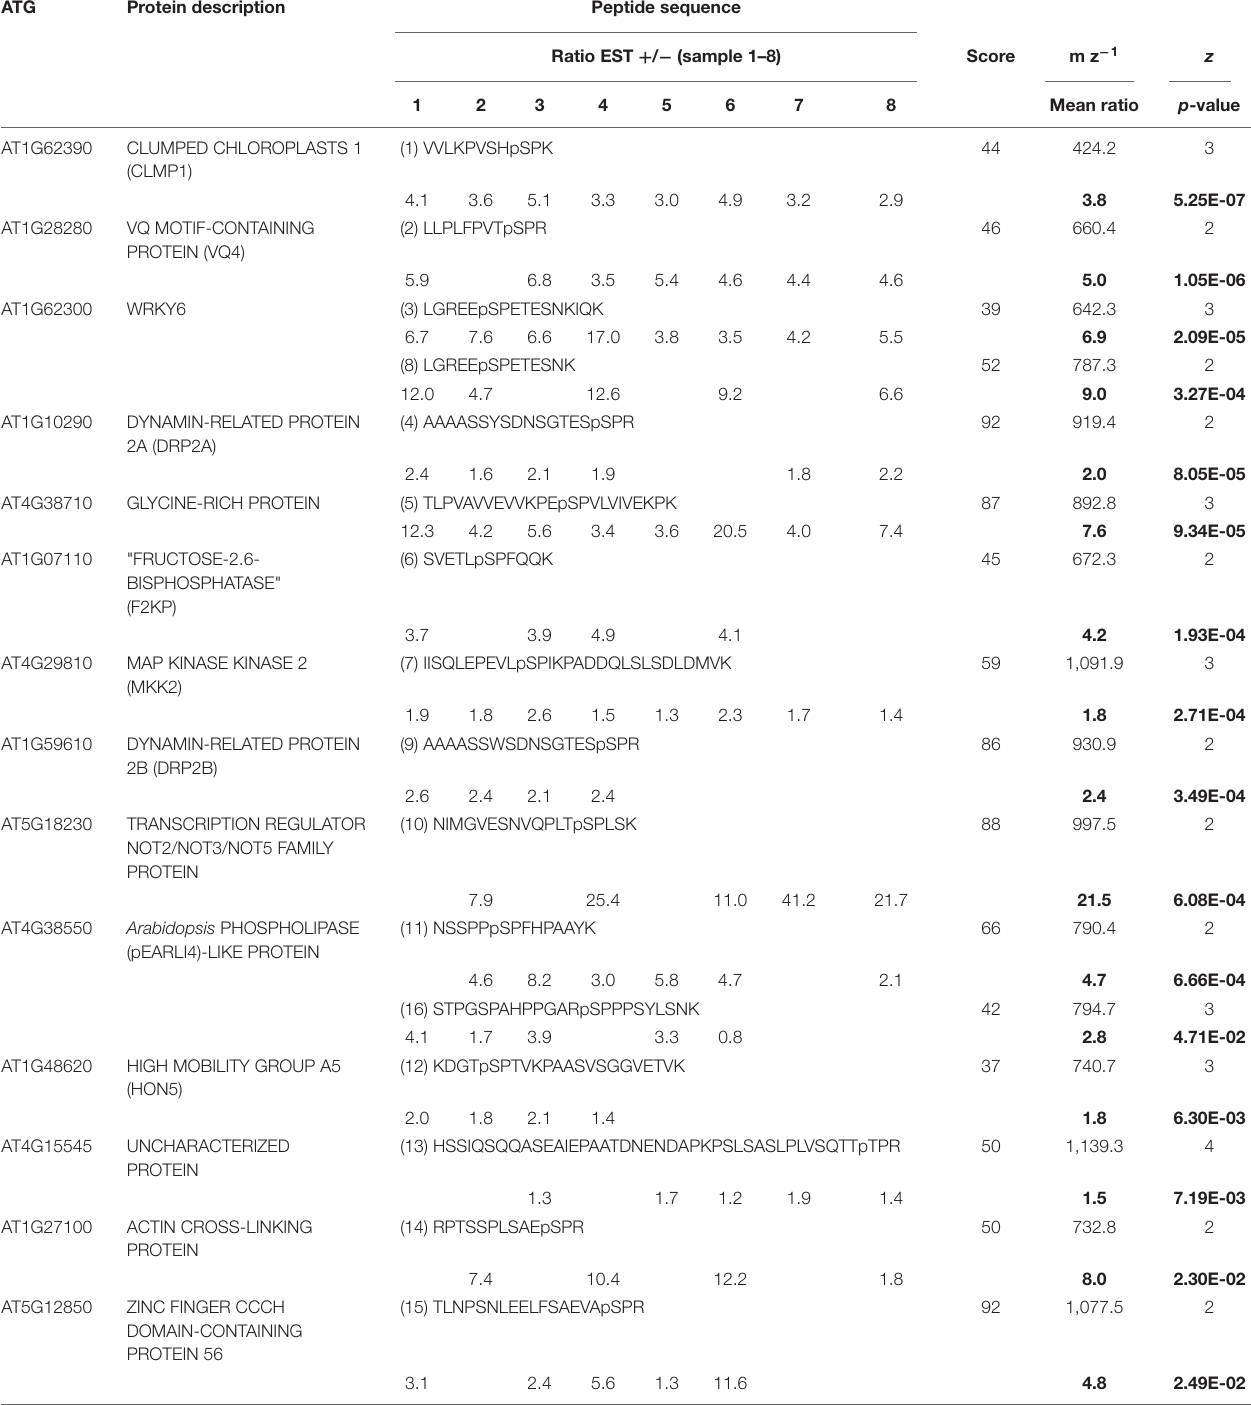
TABLE 1 | Identified and quantified in vivo substrate candidate proteins of the MKK7-MPK3/6 module. ATG Protein description Peptide sequence Ratio EST + / − (sample